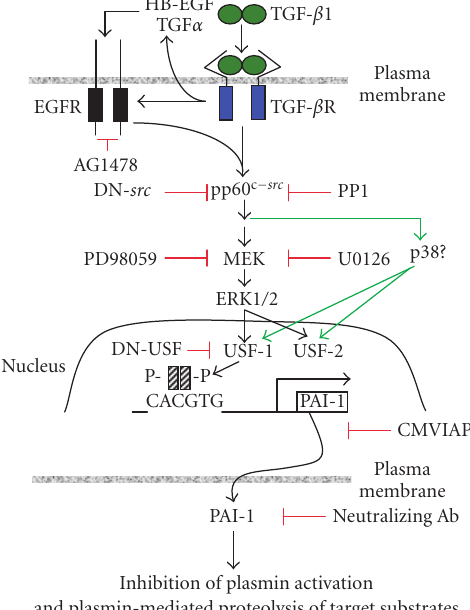
Figure 3: Pathways involved in the regulation of PAI-1 expression and function in response to TGF- β 1 stimulation. Positve influences are depicted in black arrows; e ff ective inhibitors defined pharma- cologically or by use of dominant-negative constructs (DN) are highlighted in red (detailed in [50]). CMVIAP = PAI-1 antisense expression